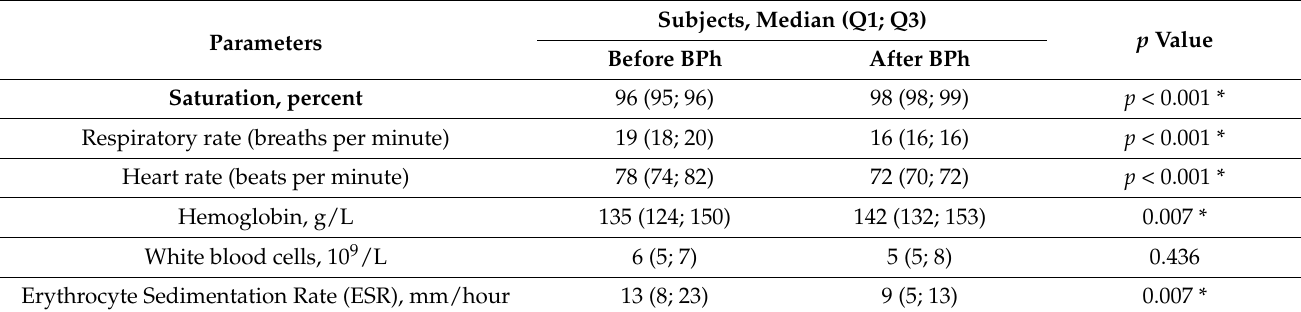
Table 1. Clinical parameters in subjects on bacteriophage therapy (BPh). Data are presented as the median and interquartile range (IQR). * Correlation is statistically significant.